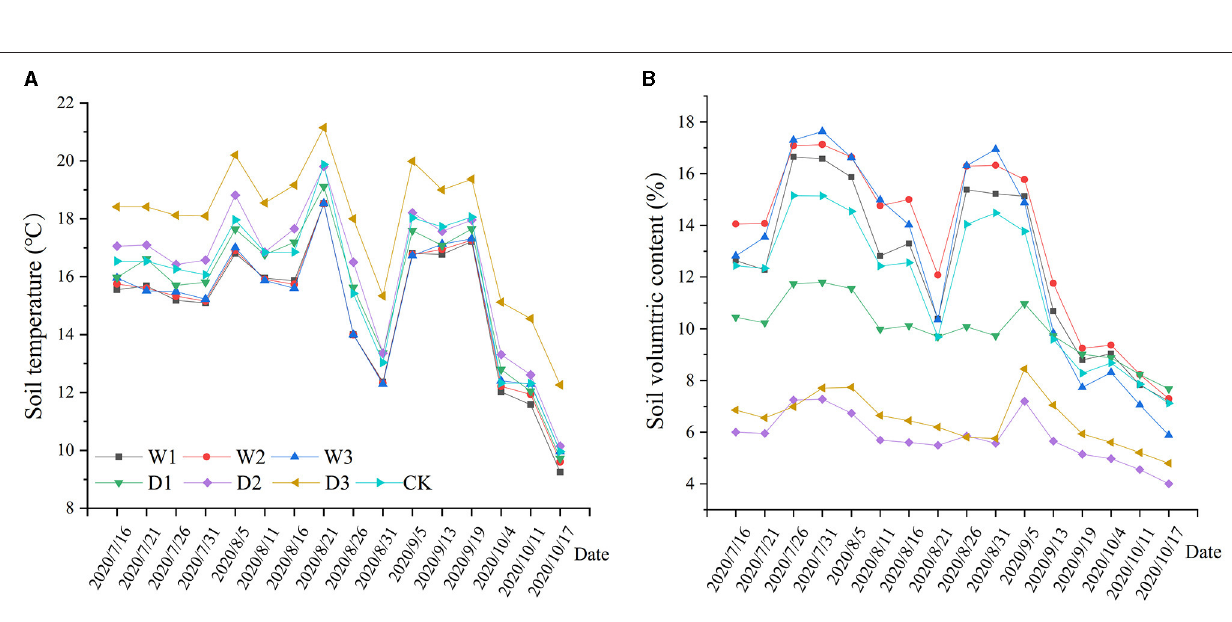
Frontiers in Ecology and Evolution |